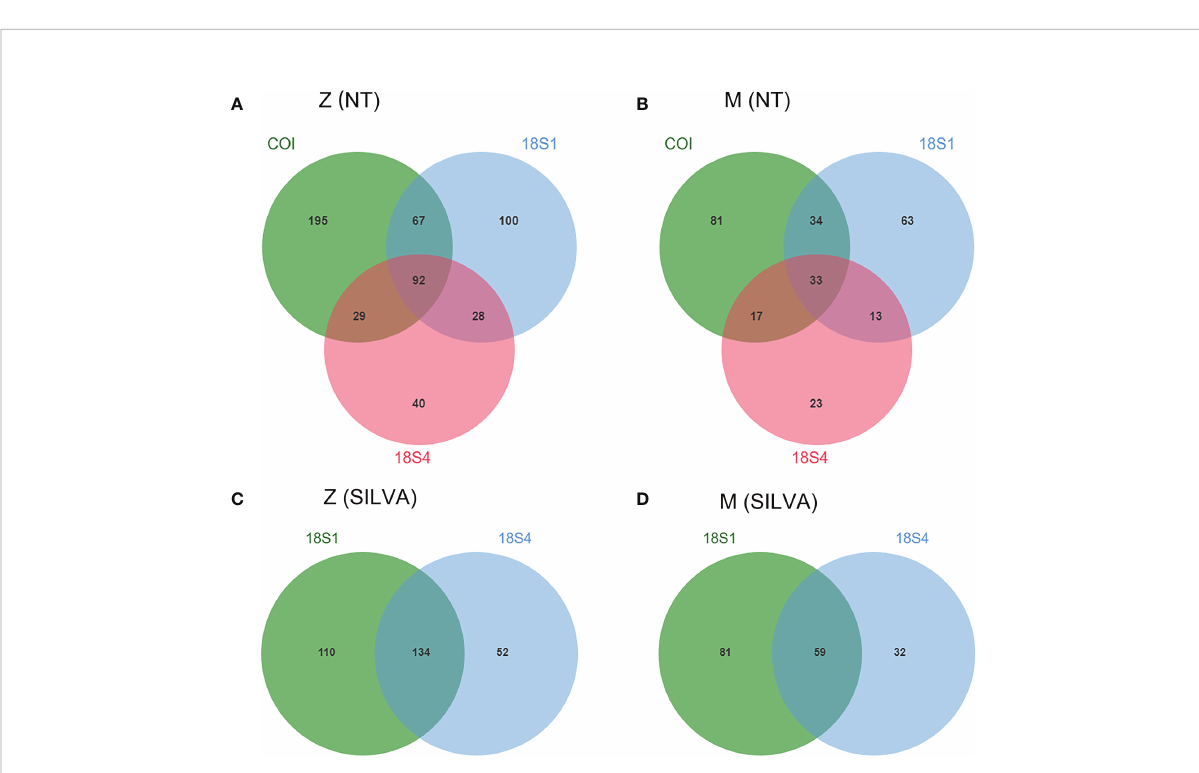
FIGURE 3 Venn diagrams showing number of families for COI, 18S1 and 18S4 against NT (A, B) and SILVA databases (C, D) . Z, zooplankton; M, meroplankton.